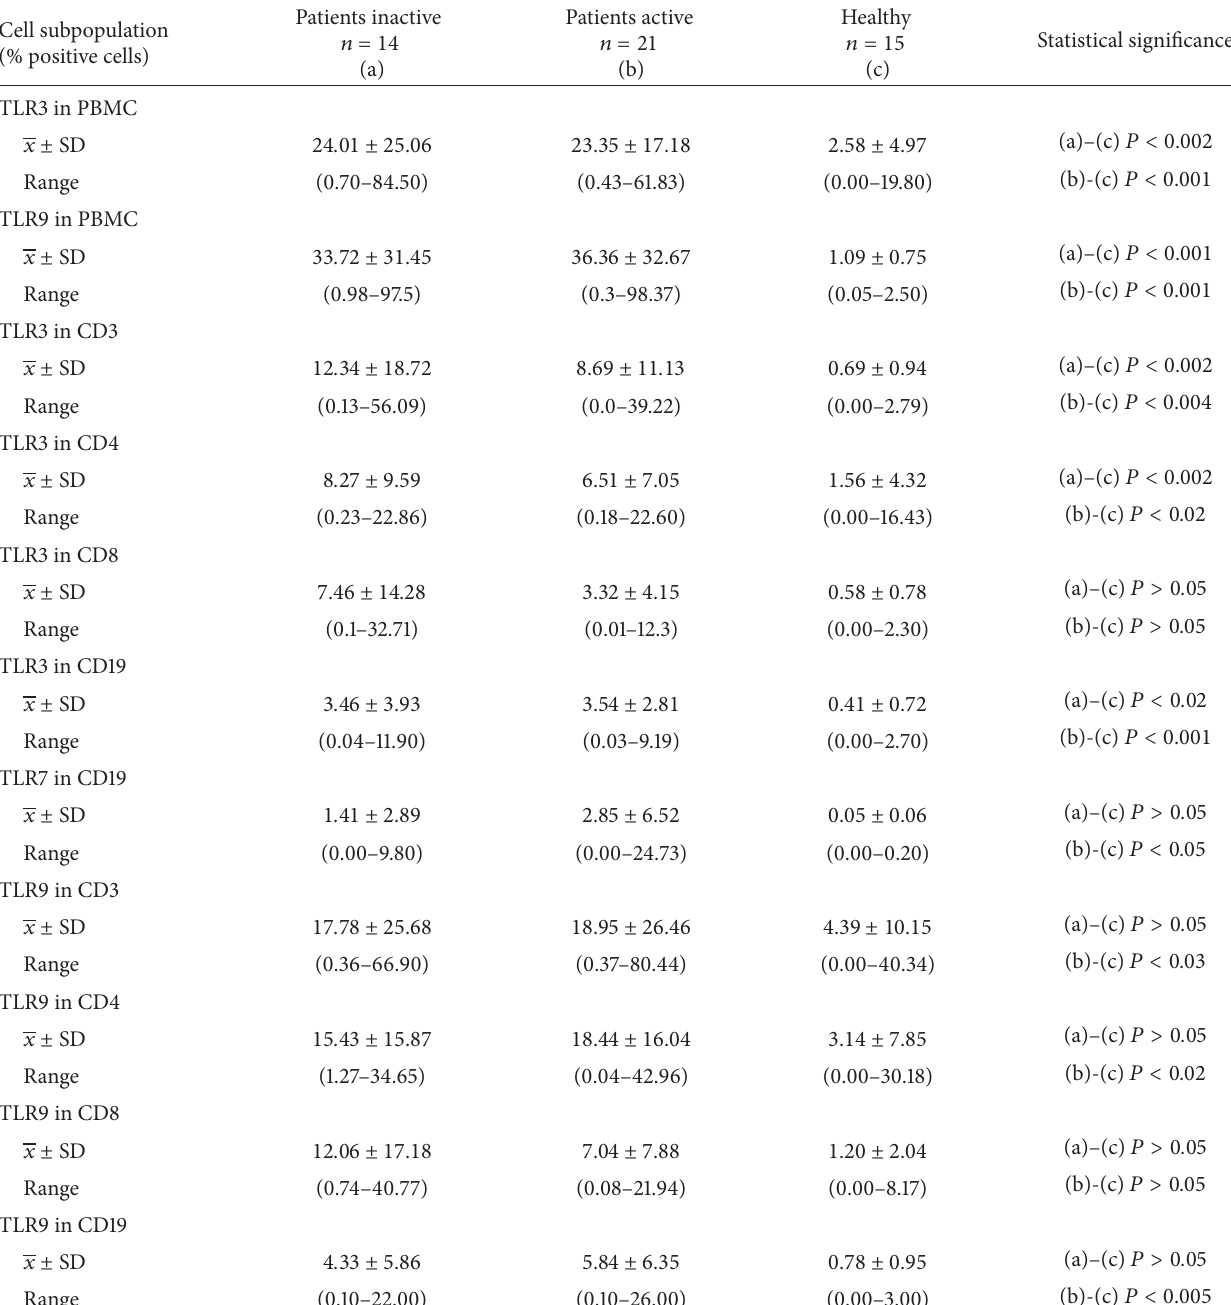
Table 2: The percentage of TLR3-, TLR7-, and TLR9-positive PBMCs and lymphocytes B CD19 + and lymphocytes T CD3 + , including CD4 + and CD8 + , in patients with SLE (active and nonactive), compared to healthy